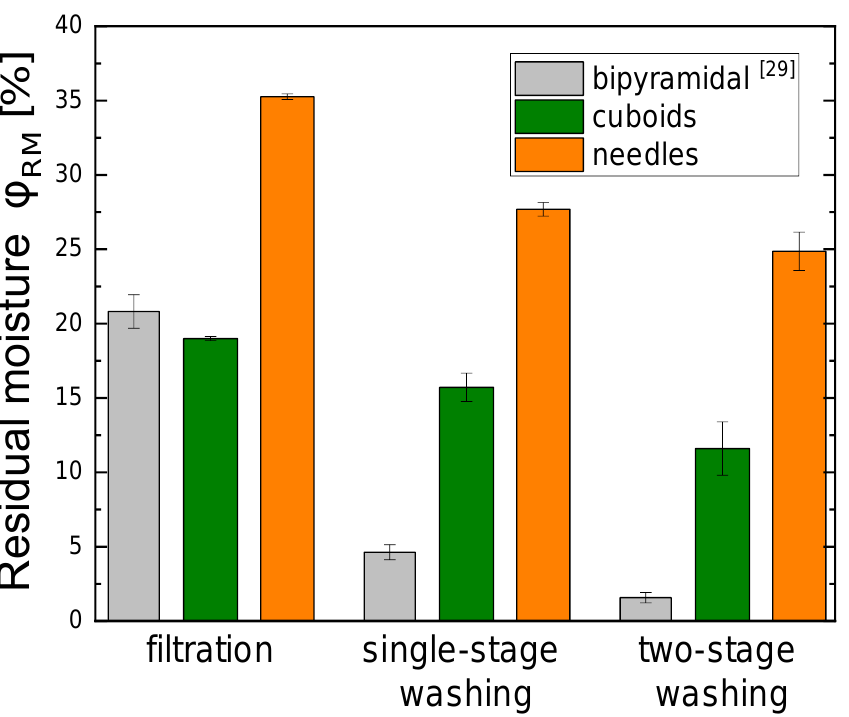
Figure 6. Averaged residual moistures of the product particles after CVSF operation of bipyramidal (grey), cuboids (green), and needles (orange).